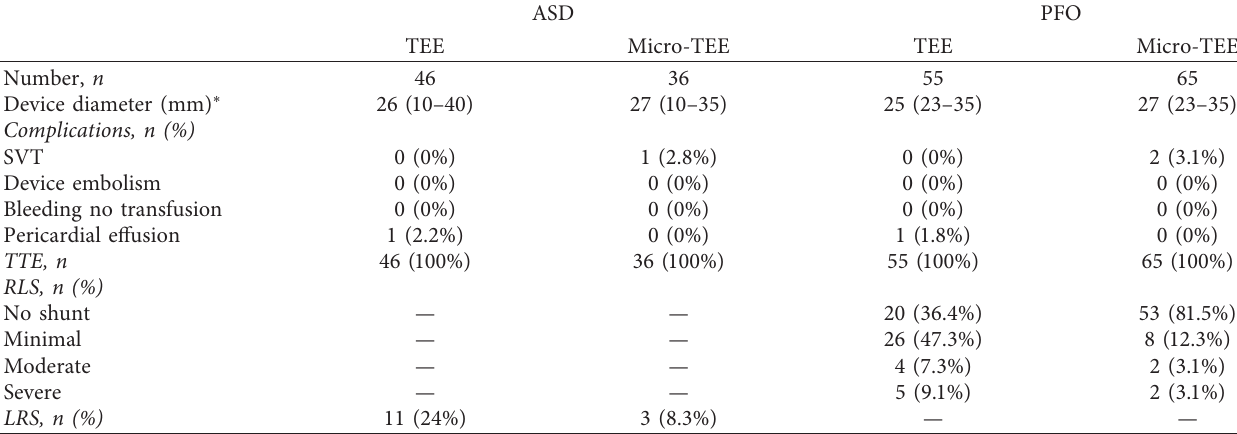
Table 2: In-hospital follow-up data after percutaneous ASD and PFO closure using TEE and micro-TEE.